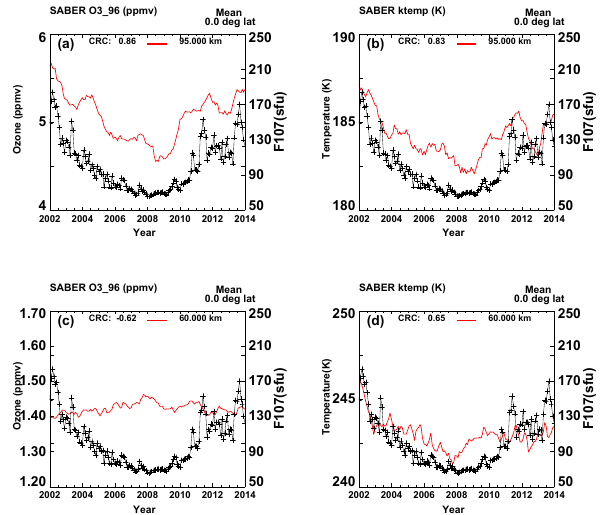
Figure 1. Top row: ozone zonal mean mixing ratios (left panel, red line) from mid-2002 to mid-2014, 95km, 0 ◦ lat; right panel, as in left panel but for temperature. Lower row: as in top row but at 60km. Black lines ( + ) show the corresponding monthly 10.7cm flux (sfu) provided by